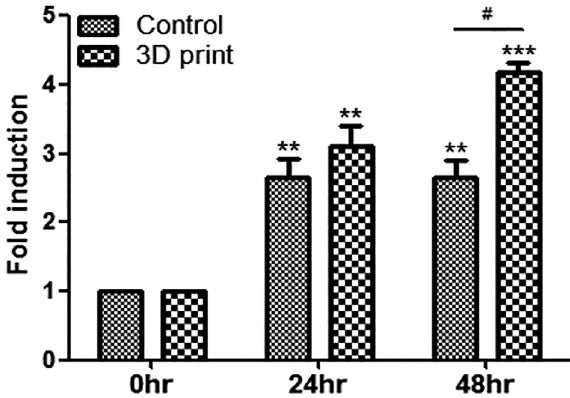
Figure 3- Results from cell viability tests